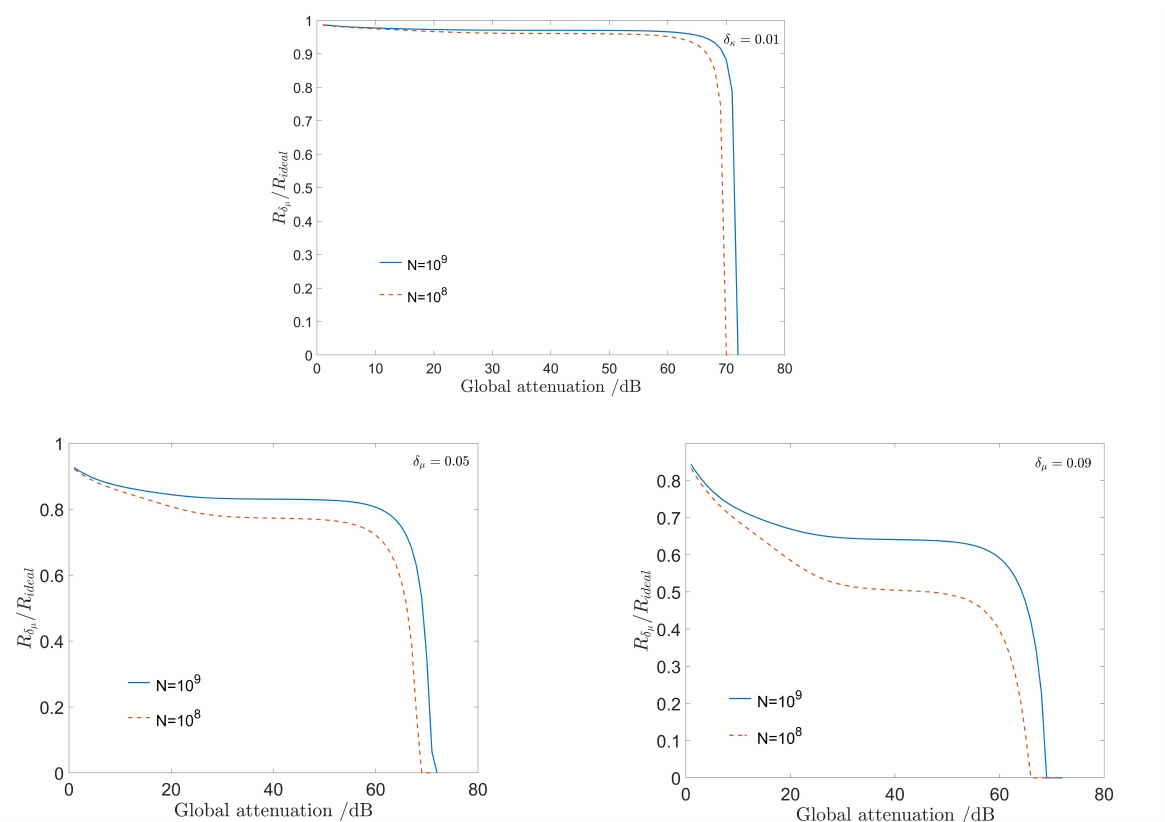
Figure 3. (Color online) R δ / R ideal vs. global attenuation for N Z = 10 8 and N Z = 10 9 with δ µ = 0, µ 0.01, 0.05,